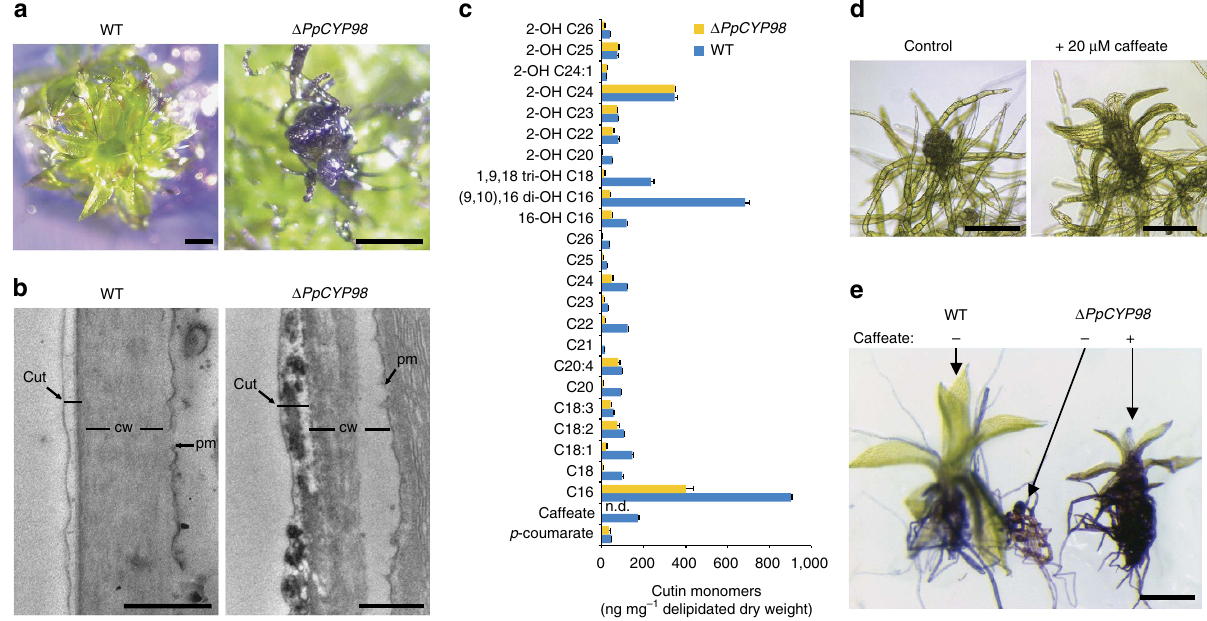
Figure 4 | PpCYP98 produces cutin caffeoyl units and is critical for cutin formation in P. patens . ( a ) Toluidine blue permeability staining indicates a cuticle defect in the D PpCYP98 mutant gametophore. Scale bars, 0.5mm. ( b ) Transmission electron micrographs of the phyllid outer cell surface showing alteration of the D PpCYP98 mutant cuticle layer. cut, cuticle; cw, cell wall; pm, plasma membrane. Scale bars, 0.5 m m. ( c ) Comparative analysis of WTand mutant cutin gametophore composition. Results are the mean þ standard error from three independent biological samples for WTand three independent lines for the mutant. n.d., not detected. ( d ) Exogenous caffeate supply (20 m M) restores growth of the D PpCYP98 mutant gametophore. Scale bars, 0.2mm. ( e ) Exogenous caffeate (20 m M) supply restores cuticle impermeability to toluidine blue of the mutant phyllids. Scale bar, 0.5mm. NATURE COMMUNICATIONS|8:14713|DOI: